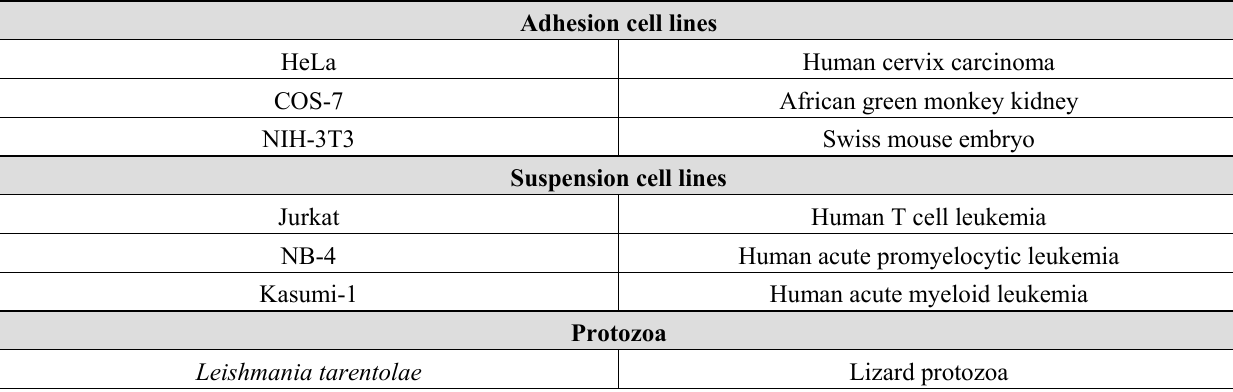
Table 3. Cell lines used in this